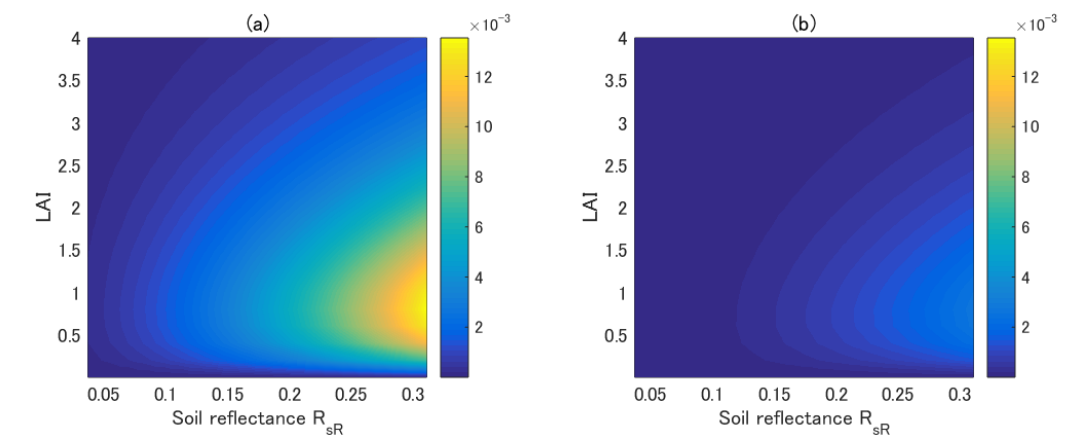
Figure 1. ( a ) Error in the first-order isoline; and ( b ) error in the asymmetric-order isoline. LAI: leaf area